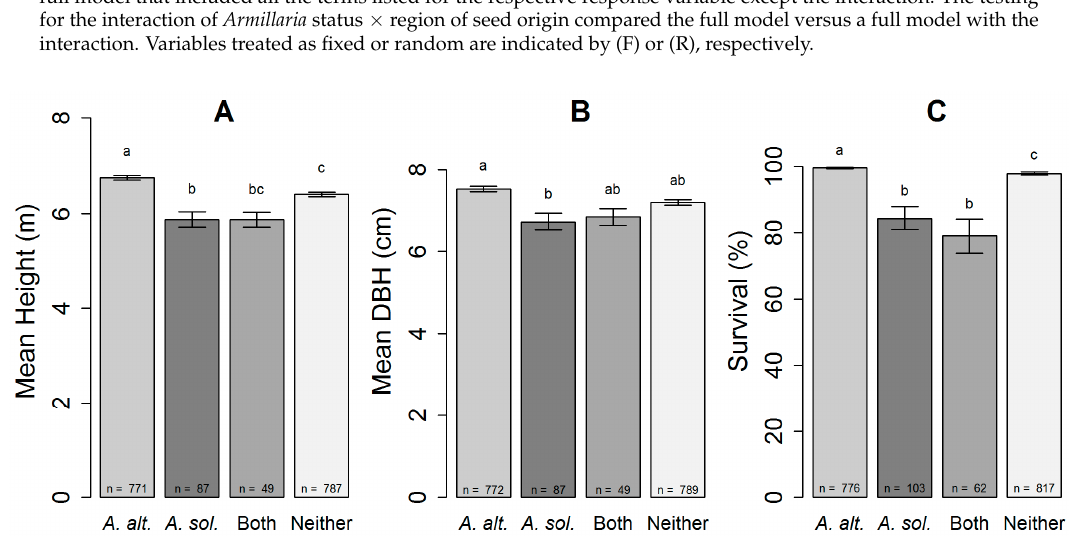
Figure 2. ( A ) The mean height, ( B ) mean diameter at breast height (DBH), and ( C ) percent survival among western white pine ( Pinus monticola ) growing in association with Armillaria altimontana ( A. alt .), A. solidipes ( A. sol .), both A. altimontana and A. solidipes (Both), or neither Armillaria species (Neither) at 16 years post-planting at the Priest River Experimental Forest, northern Idaho, USA. The height and DBH measures were not available for every live tree in the dataset. The bars show the standard error. Means sharing a lower case letter within each bar graph (i.e., A, B, and C) are not significantly different ( p < 0.05) by Tukey-adjusted means separation.